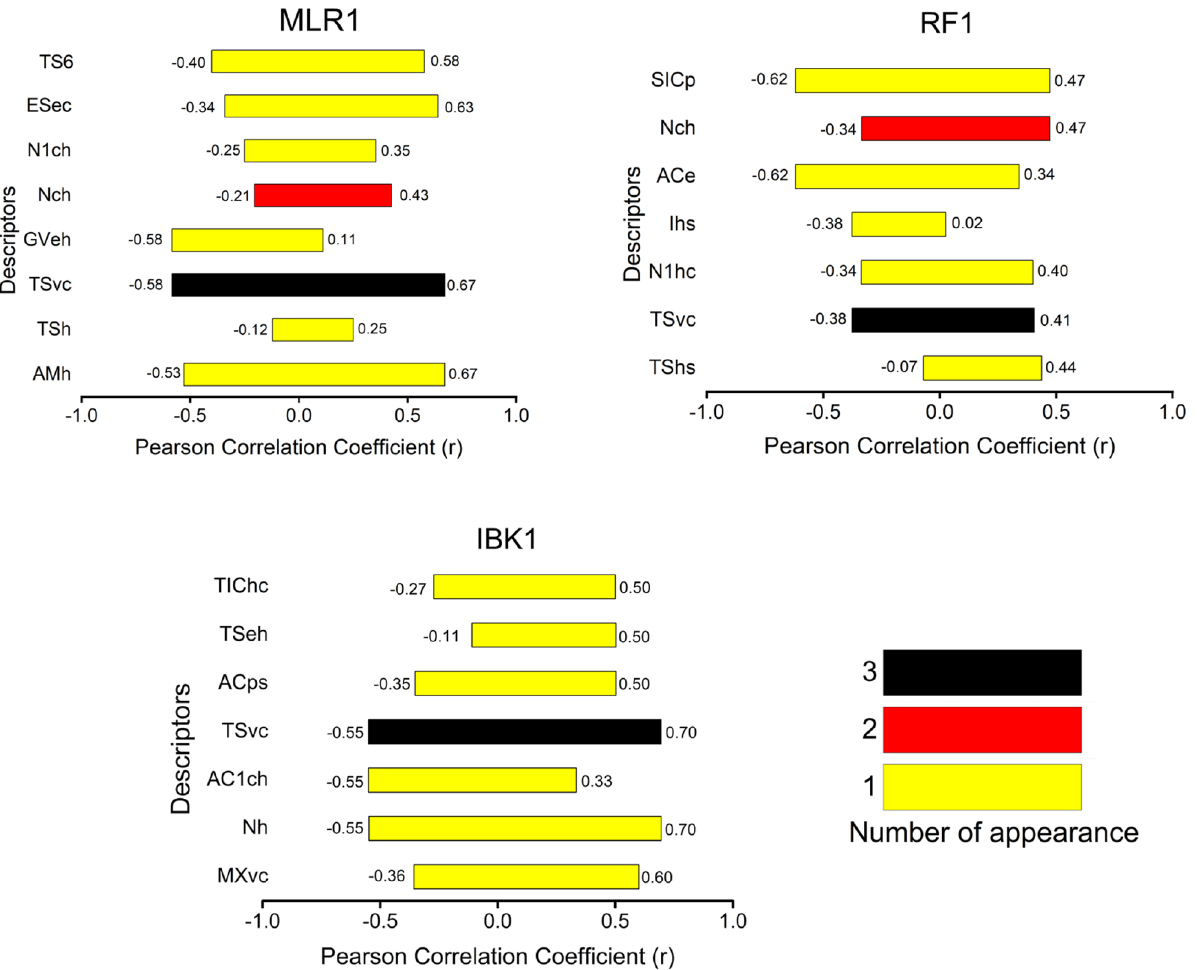
Figure 4. Graphical representation of the maximum and minimum values of Pearson correlation coefficients (r) for each descriptor vs the rest in MLR1, RF1 and IBK1 models. Values for the corresponding correlation matrix are presented in Tables S4, S5 and